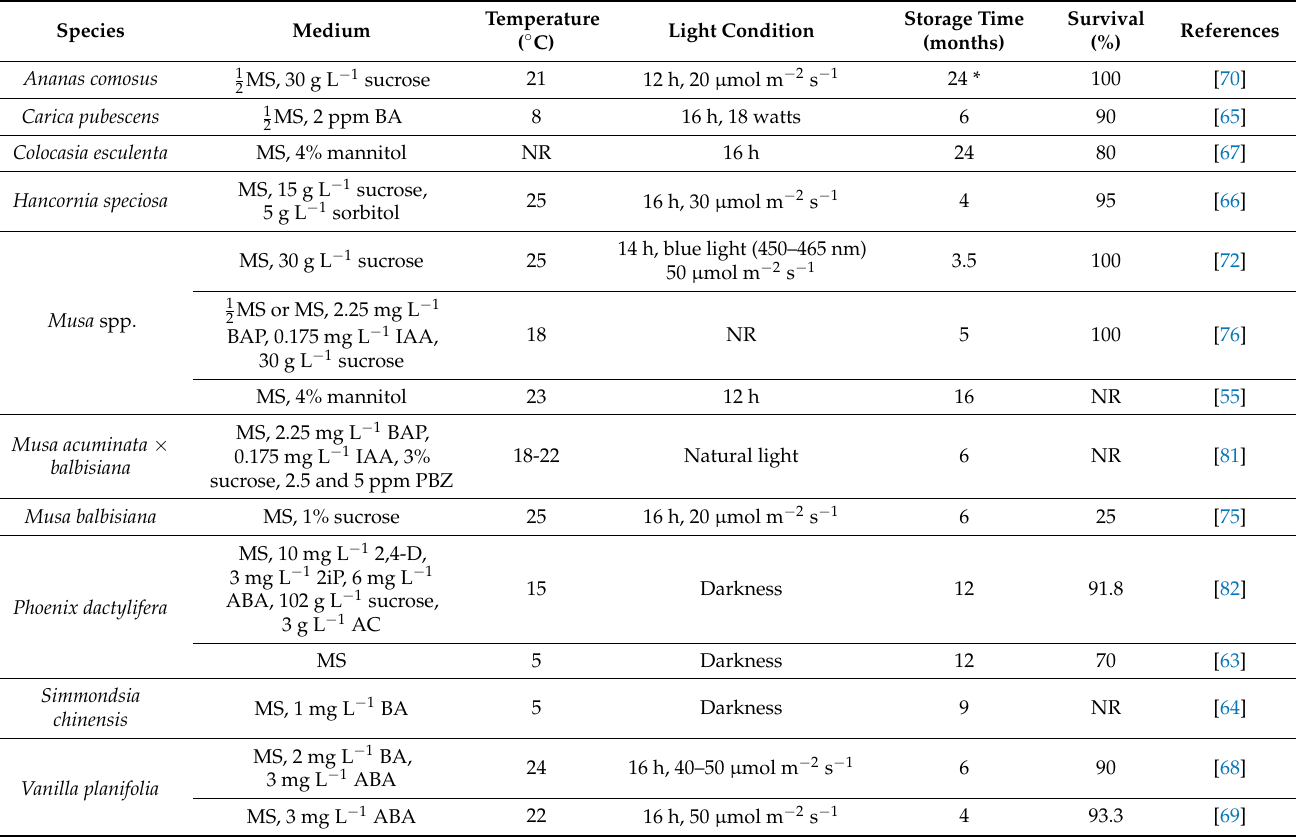
Table 2. Tropical fruit shoots conservation in SGS from 2012 to present. Culture conditions and best results are reported for each species (terminology and values are the same as mentioned by the